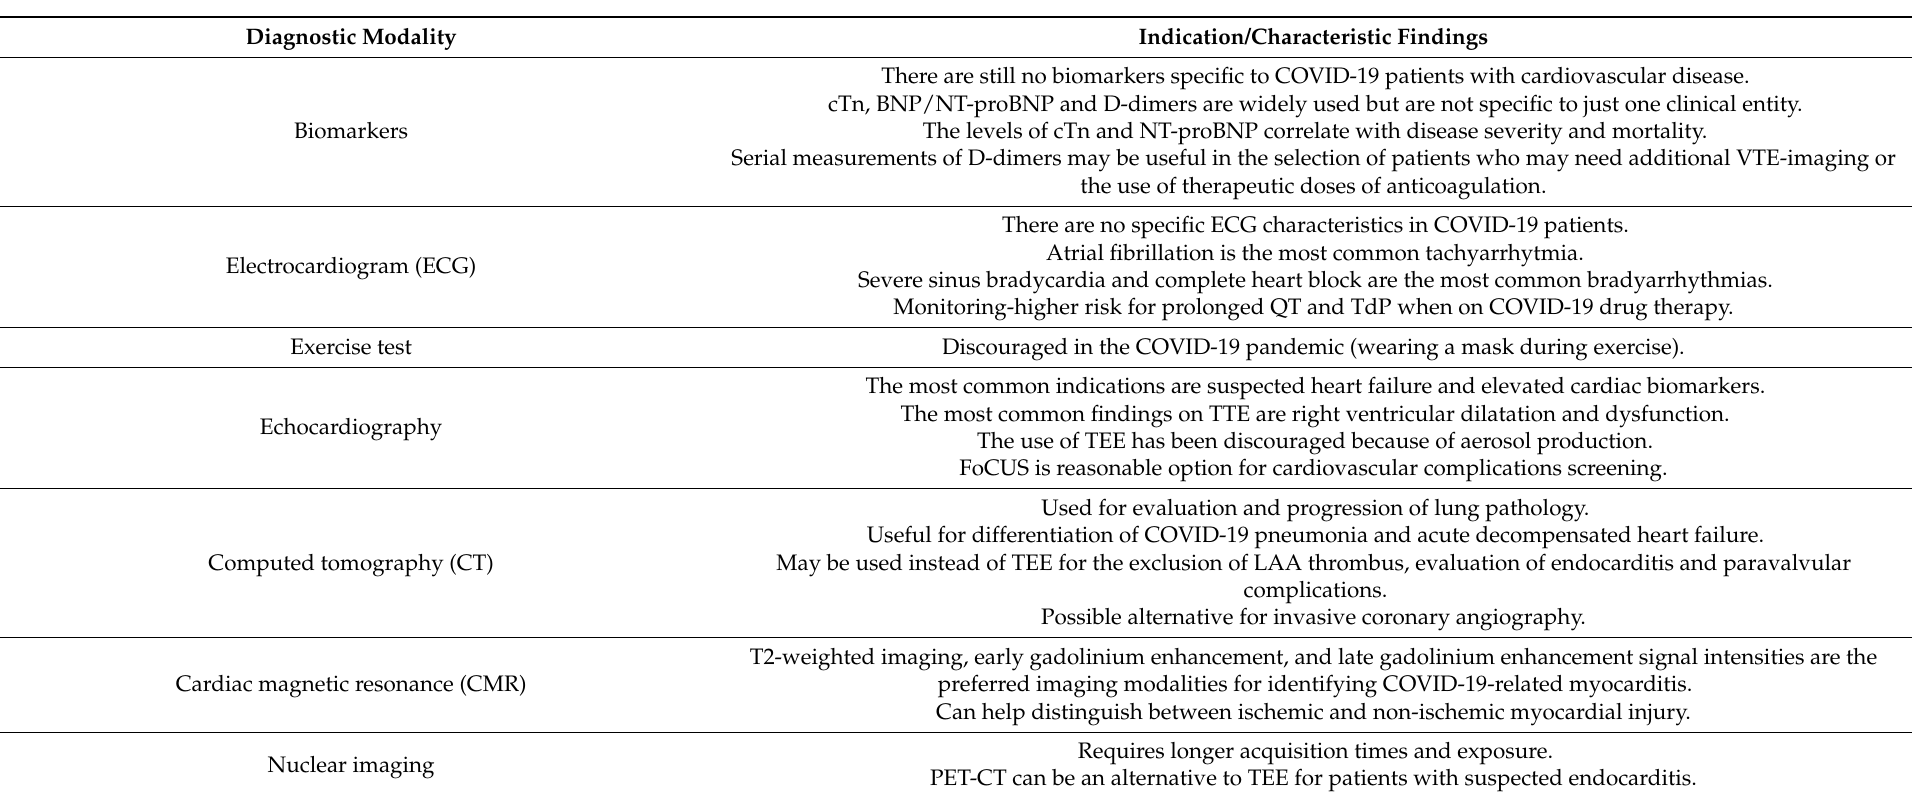
Table 1. Diagnostic approach for the cardiovascular complications of COVID-19 and their characteristic